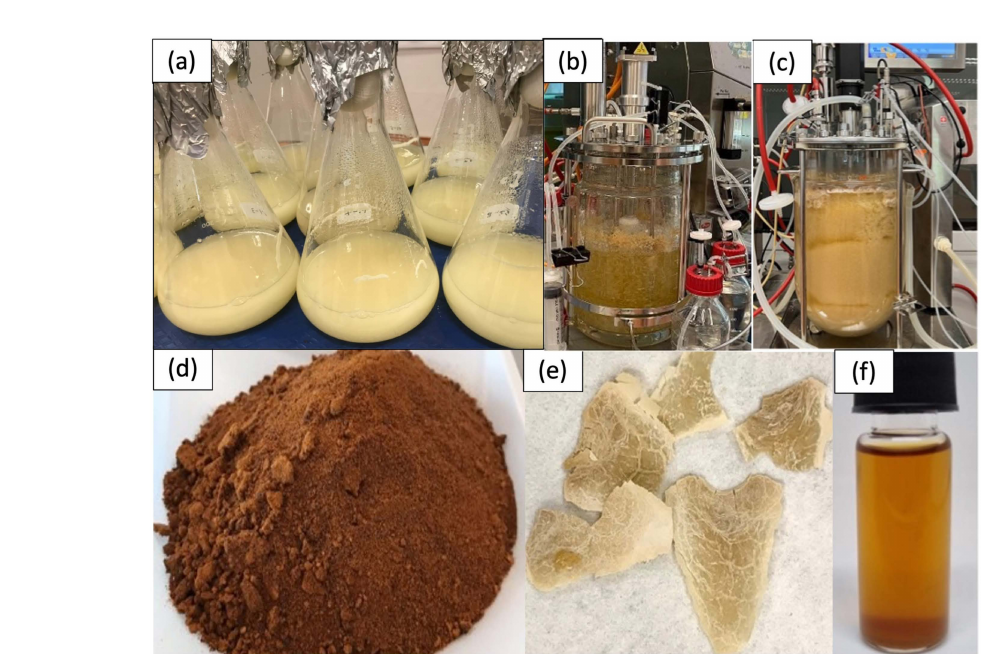
Figure 5. The stages of L. rhinocerus cultivation in submerged liquid fermentation (SLF) and its products: ( a ) seed culture in shake flasks, ( b ) cultivation in a 5 L STR bioreactor after 7 days of the fermentation process, ( c ) cultivation in a 13 L STR bioreactor after 11 days of the fermentation process, ( d ) powdered MB, ( e ) dried EPS, and ( f ) oil production from